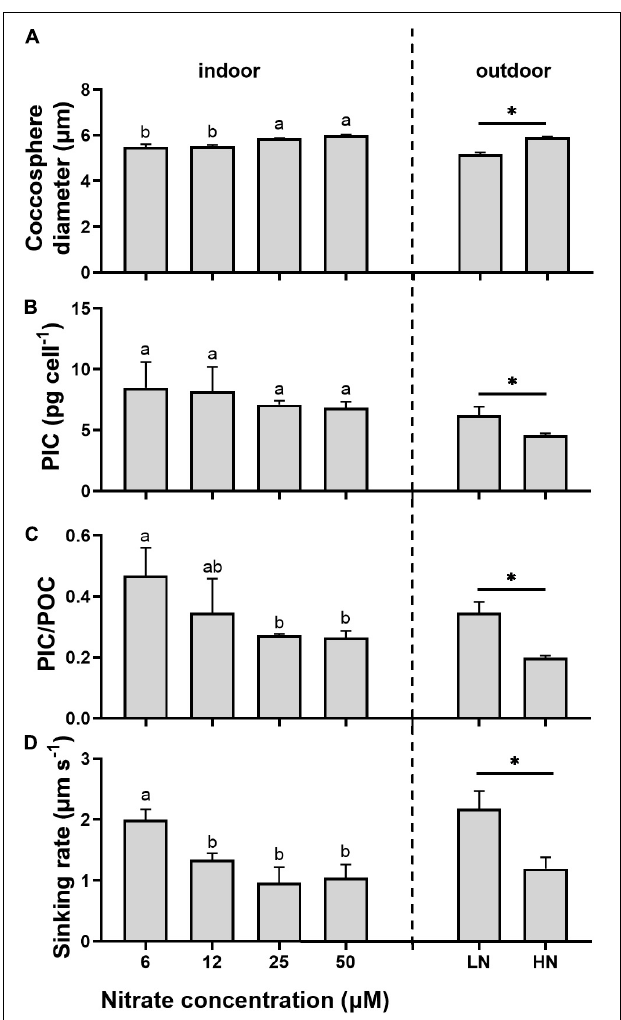
FIGURE 3 | The coccosphere diameter (A) , cellular particulate inorganic carbon (PIC) quotas (B) , PIC/particulate organic carbon (POC) ratio (C) , and sinking rate (D) of Gephyrocapsa oceanica cells grown under different levels of nitrate under indoor and outdoor light conditions. Values are the means ± SD of triplicate cultures. Symbols with different lowercase letters and ∗ indicate significant differences among different treatments ( p < 0.05). The difference is not significant if there the letters above the columns are the same or their combinations, completely different letters indicate significant changes.